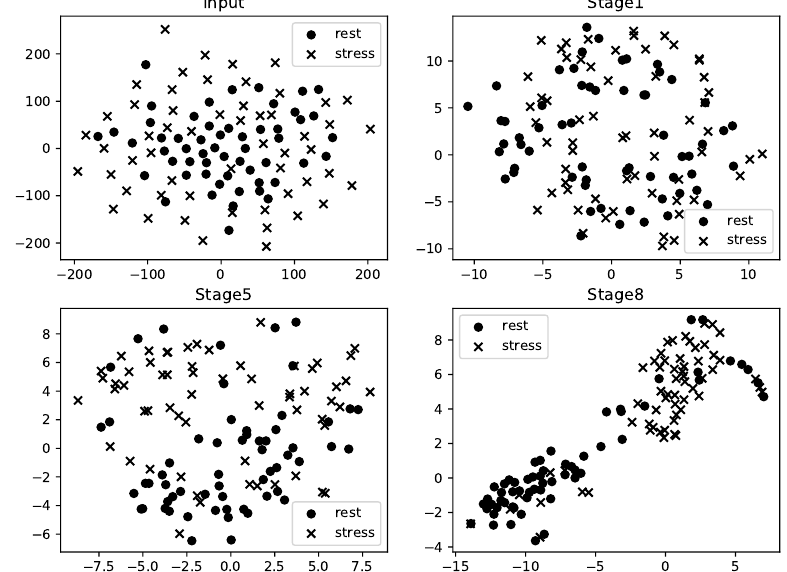
Figure 3. The t-SNE plots of raw ECG and extracted features from the stages. Round points denote features of ECG labeled as rest, and crosses represent stress-labeled features. This figure shows only the extracted features from stage 1, stage 5, and the last